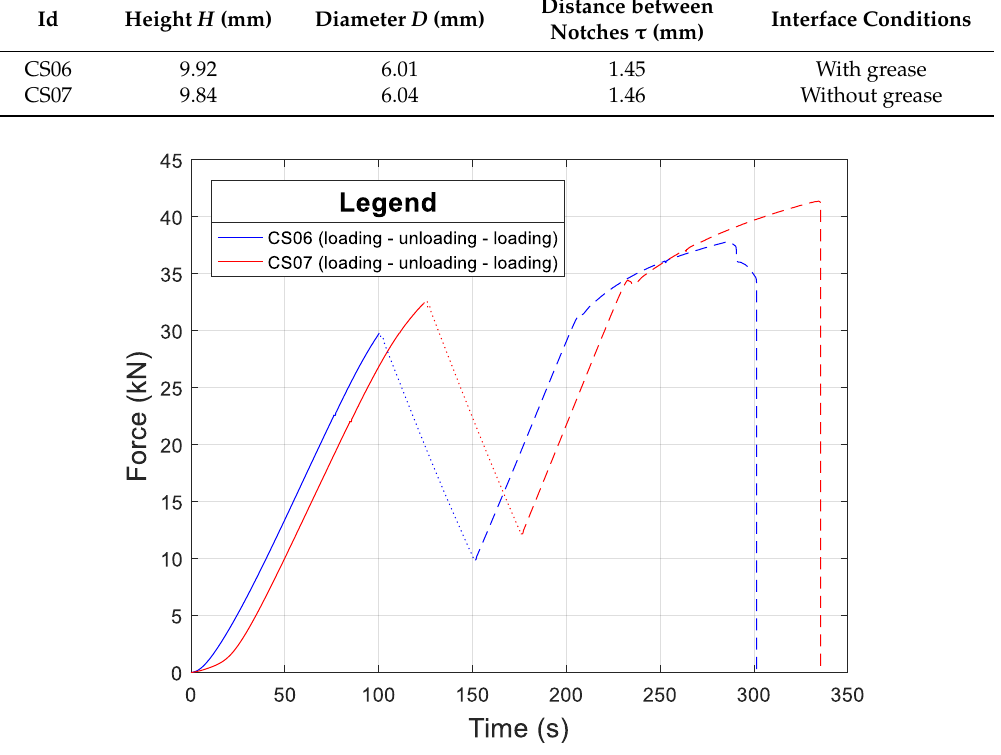
Figure 5. Cycles and loading conditions for quasi-static compressed samples.